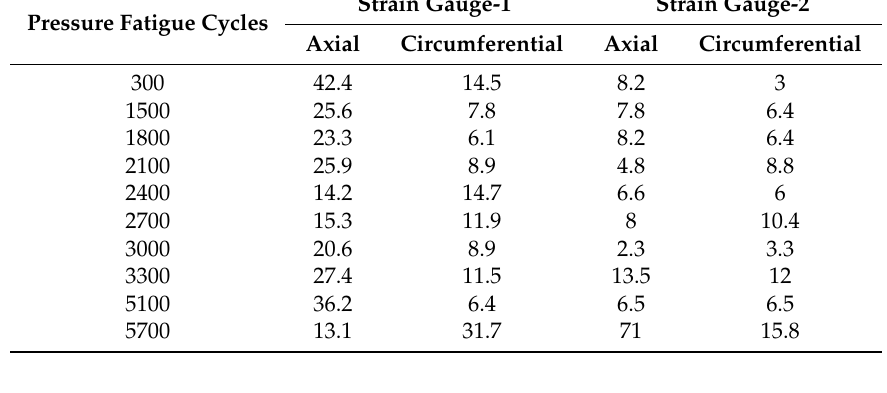
Figure 13. Monitoring results by the MWCNT sensor and the stain gauge when the filament wound pressure vessel is in 5100- to 5700-fatigue cycles. The strain was measured by strain gauge-2 in Figure 4. ( a ) Resistance, the stain as the function of fatigue time. ( b ) The enlarged drawing curves.